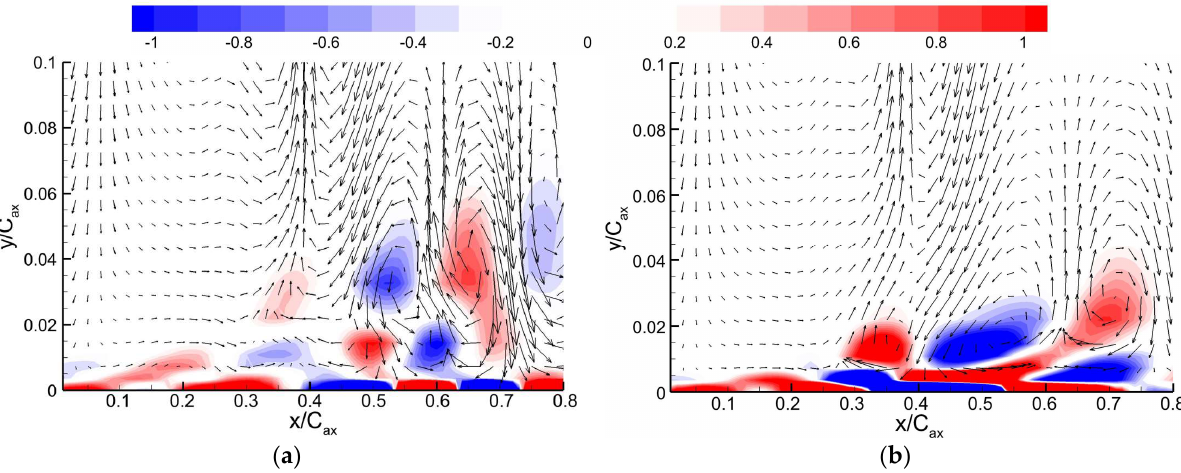
Figure 15. Distribution of the transient disturbance vorticity on the suction surface at 50% span. ( a ) Re = 1 × 10 5 ; ( b ) Re = 4 × 10 5 .